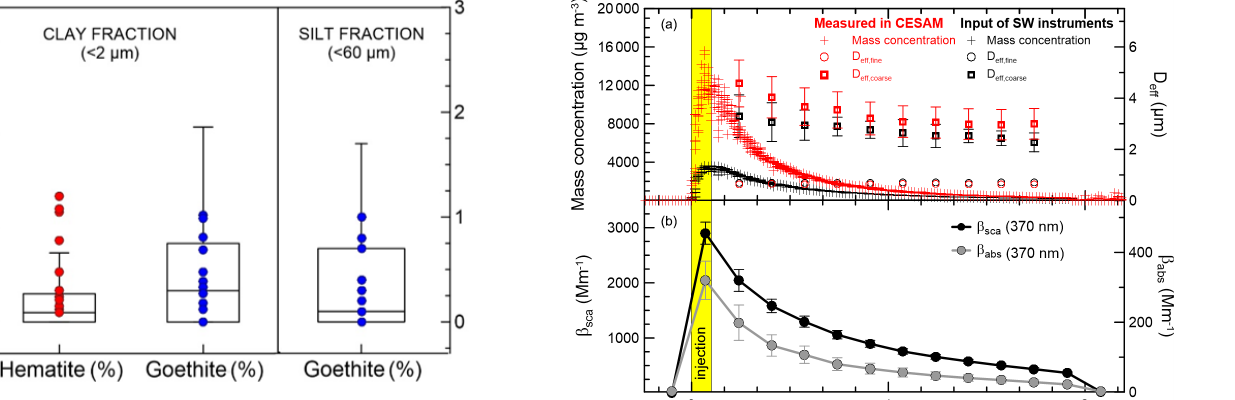
Figure 2. Box-and-whisker plot showing the full variability of hematite and goethite mass fractions in the soils for the clay-sized (<2µm diameter) and silt-sized (<60µm diameter) fractions as re- trieved from the global soil mineralogical database by Journet et al. (2014). The box-and-whisker plot includes data for the nine desert source areas depicted in Ginoux et al. (2012) and DB17 (northern Africa, Sahel, eastern Africa and the Middle East, cen- tral Asia, eastern Asia, North America, South America, southern Africa, and Australia). Dots indicate hematite and goethite content in clay-sized and silt-sized soils (always from Journet et al.) ex- tracted in correspondence to the geographical coordinates at which the 19 soils used in the CESAM experiments were collected. The Journet et al. database assumes that the iron oxides in the silt frac- tion consist only of goethite.